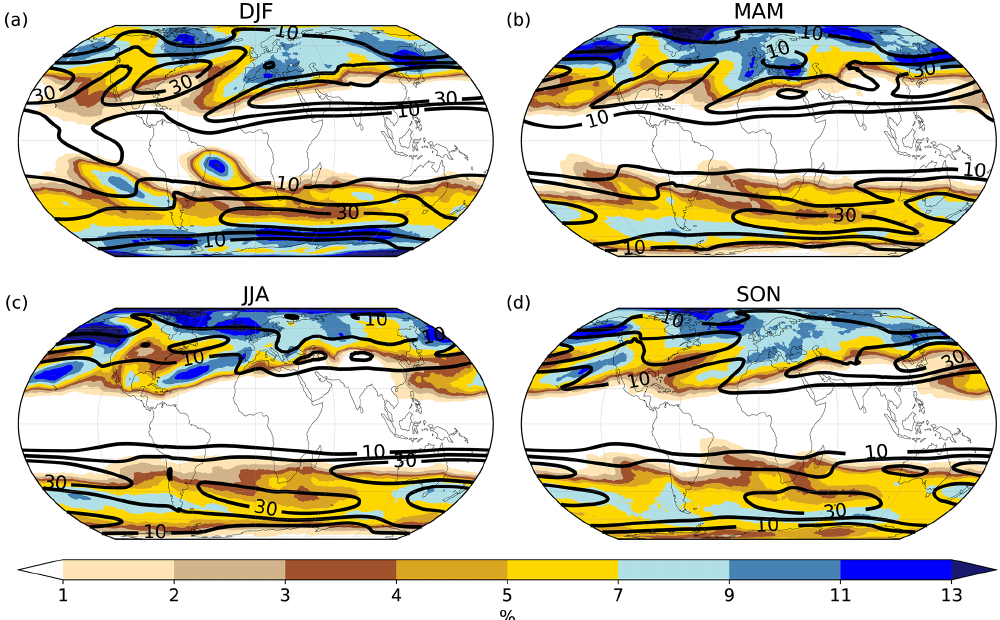
Figure 3. Seasonally averaged PV cutoff frequencies (shading, in %) and zonal wind speed (thick black line, 10, 20, and 30ms − 1 ) for (a) DJF, (b) MAM, (c) JJA, and (d)